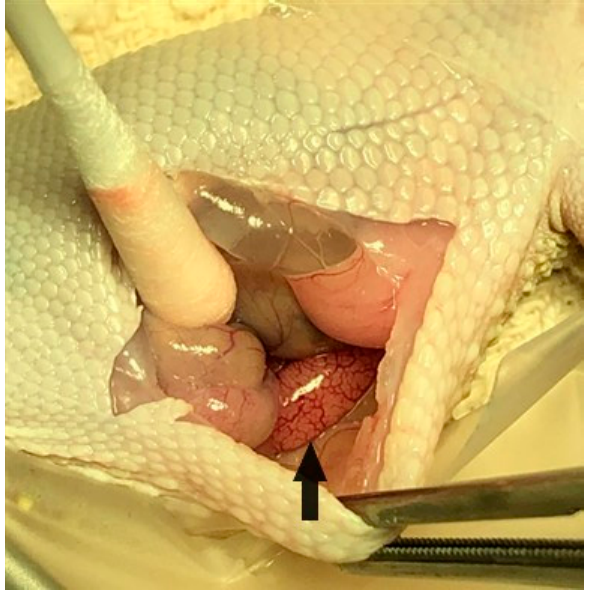
Figure 3. Visualization of right testicle (arrow) in body cavity prior to removal.